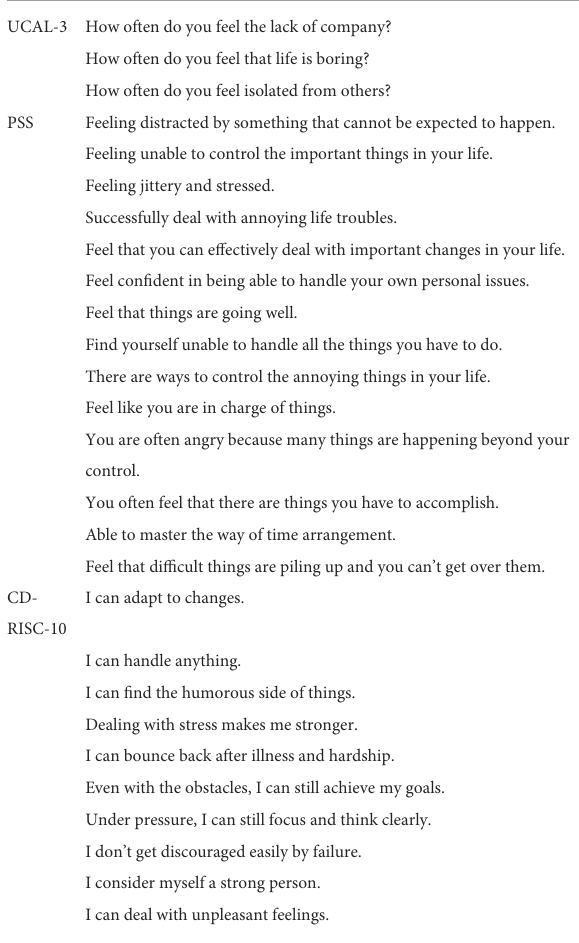
TABLE 1 Scale items of UCAL-3, PSS and